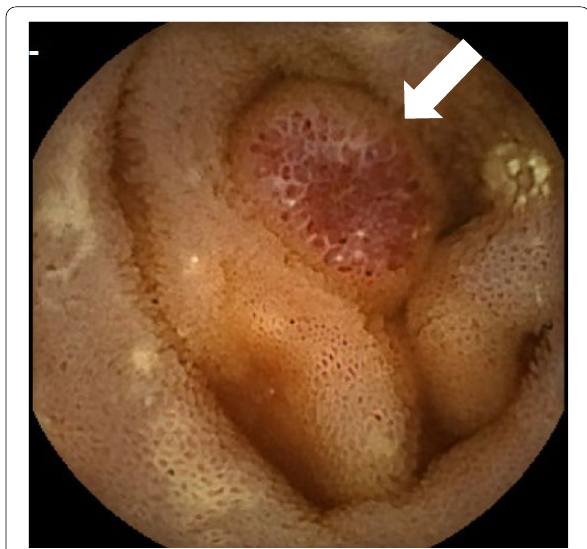
Fig. 3 Capsule enteroscopic delineation of multiple lymphangiomas at jejunum and terminal ileum: the surface was yellowish-white with reddish color and finely granular